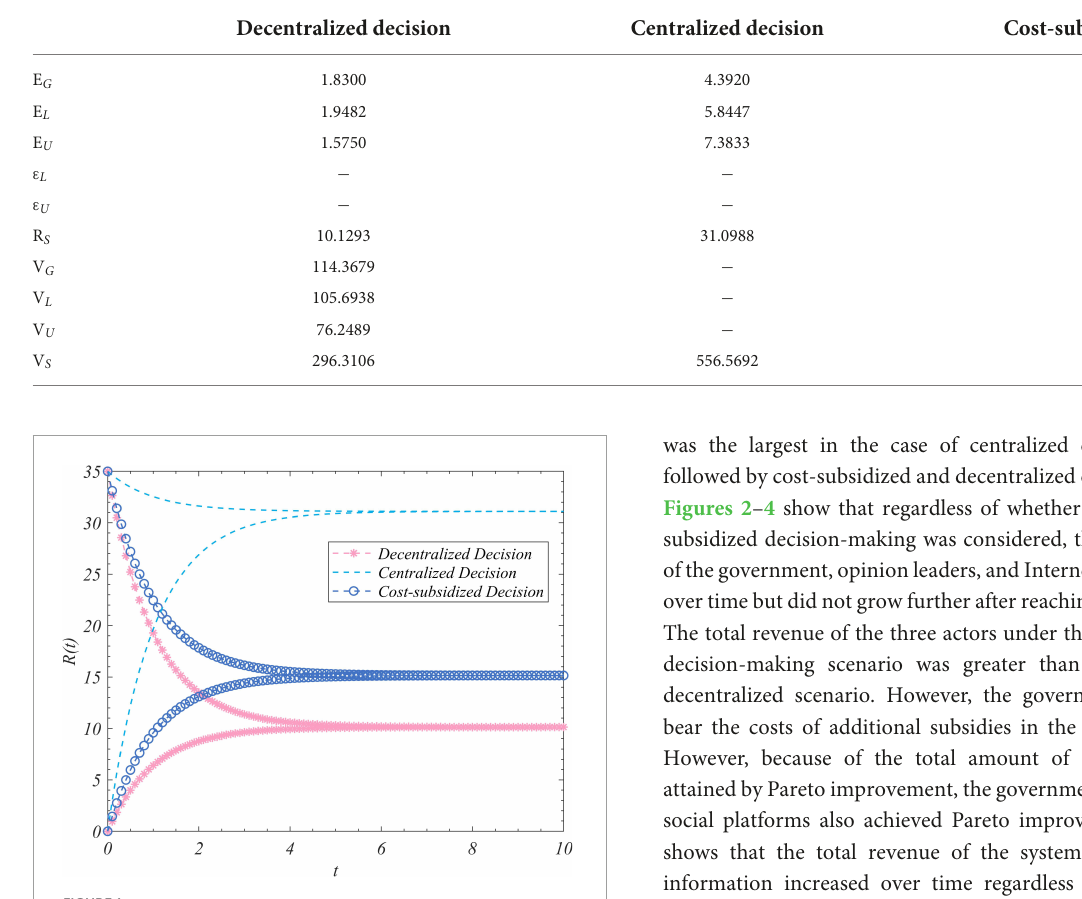
FIGURE1 The trajectories of the evolution of the total amount of real information in the cases of decentralized, centralized, and cost-subsidized decision-making when R 0 = 0 and 35.